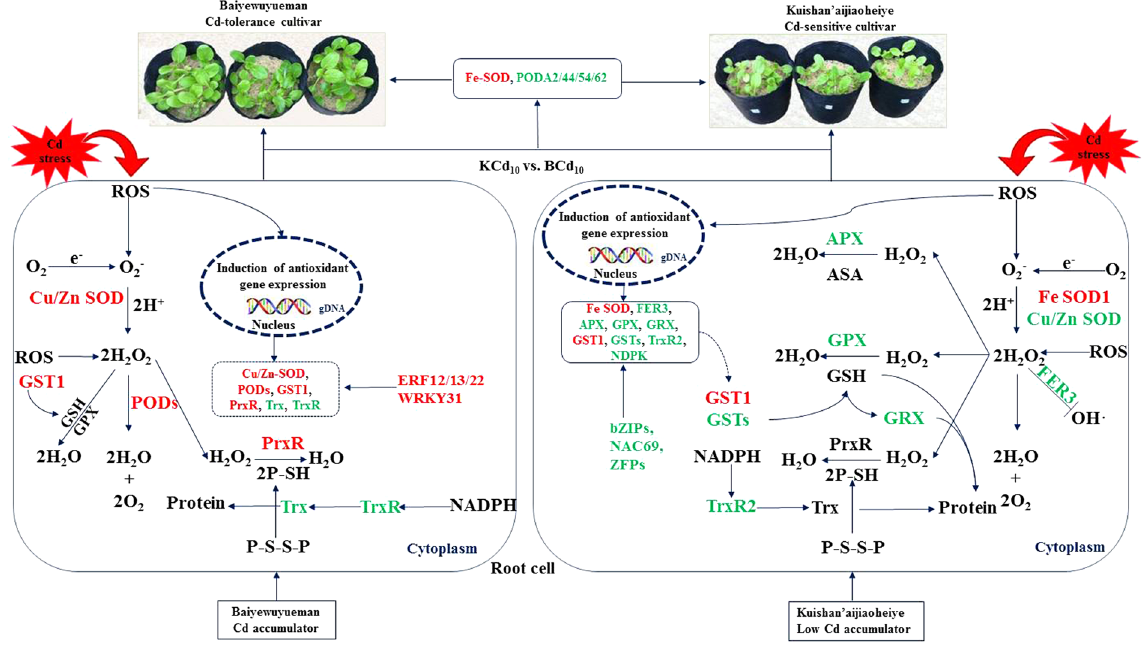
Figure 5. The putative model of regulatory networks associated with ROS scavenging system in response to Cd exposure in roots of two pak choi cultivars. Red fonts indicate the genes up-regulated, green fonts indicate the genes down-regulated in two cultivars exposed to Cd as compared to their respective